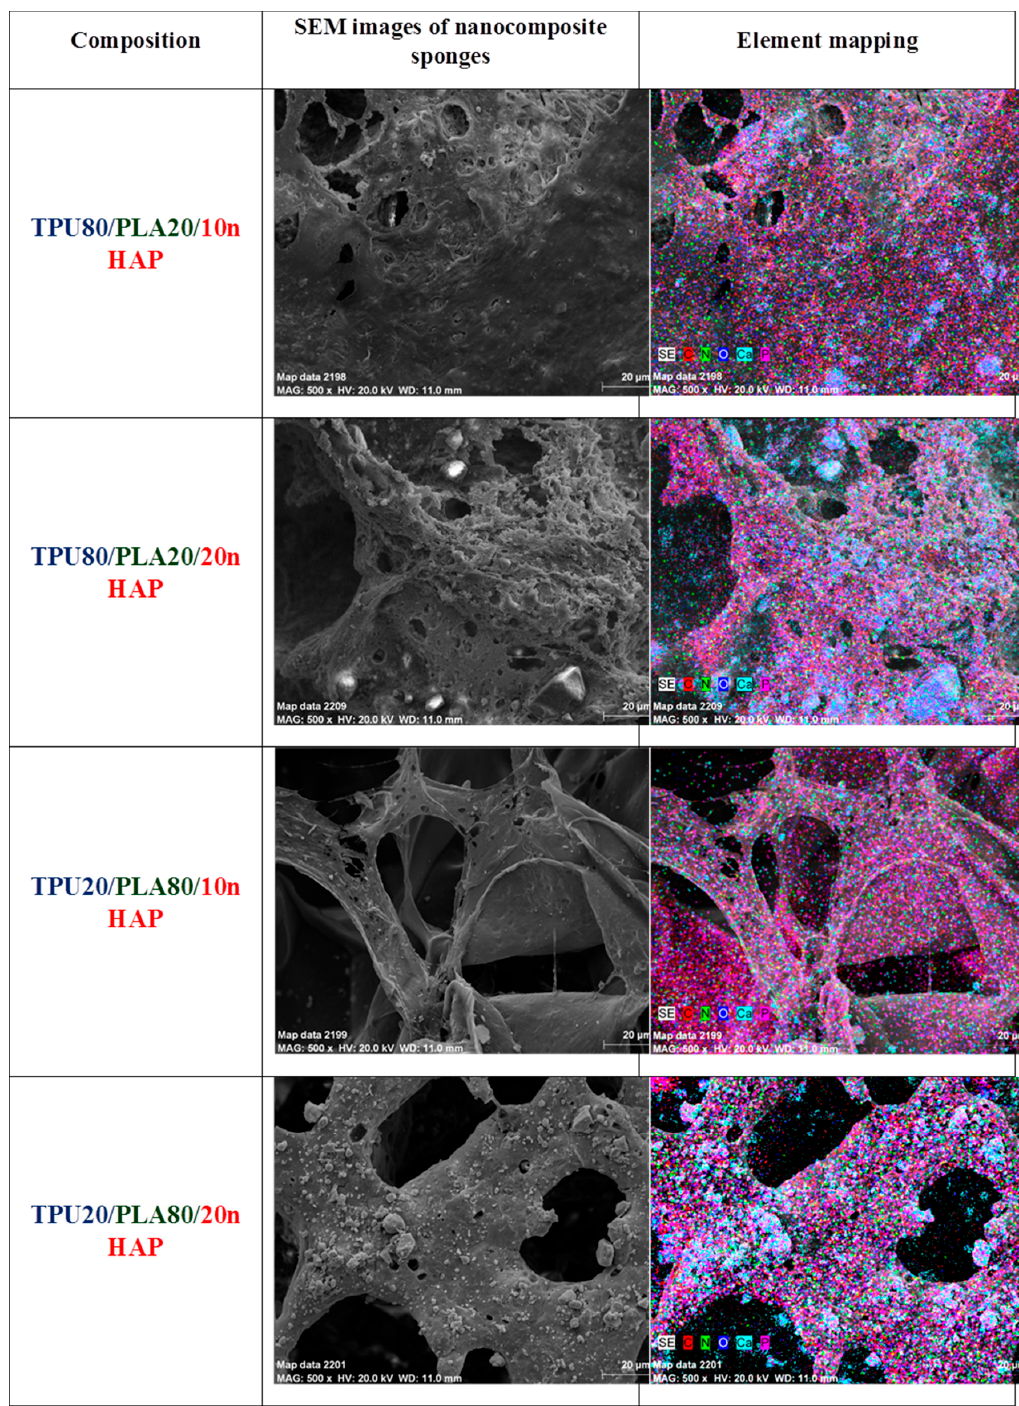
Figure 4. Elemental mapping on the TPU/PLA/nHAP sponge surface: C (red), N (green), O (blue), Ca (cyan), and P (magenta), magnification 500×.